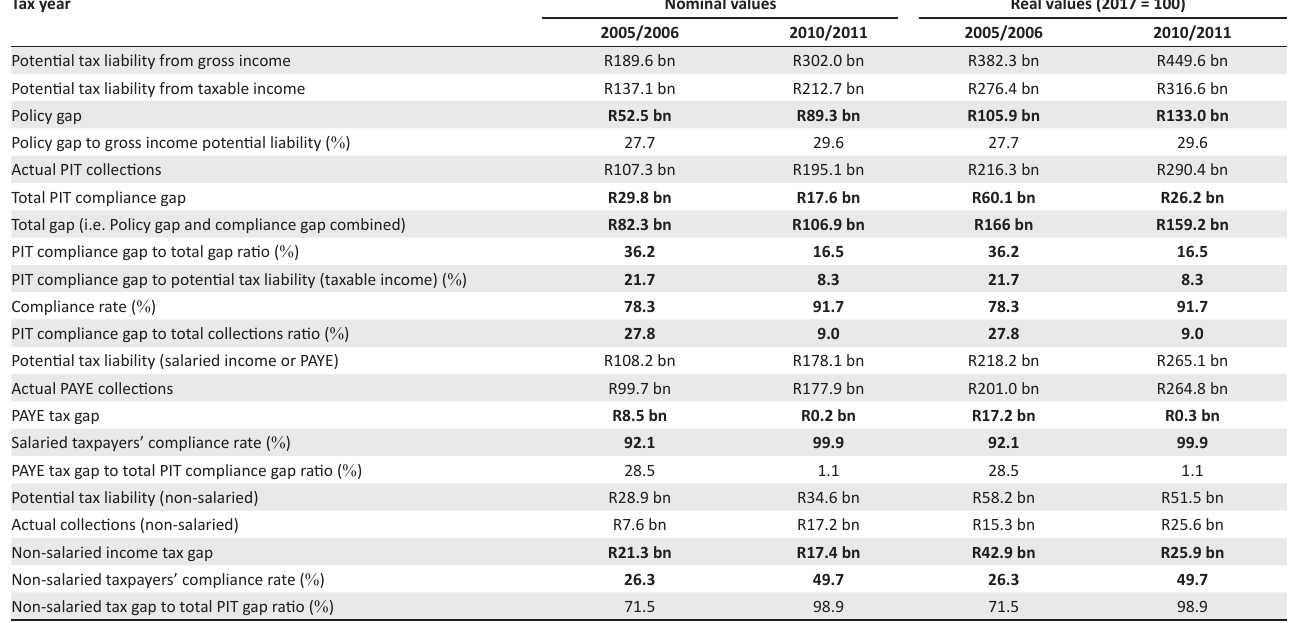
TABLE 3: Summary of tax gap